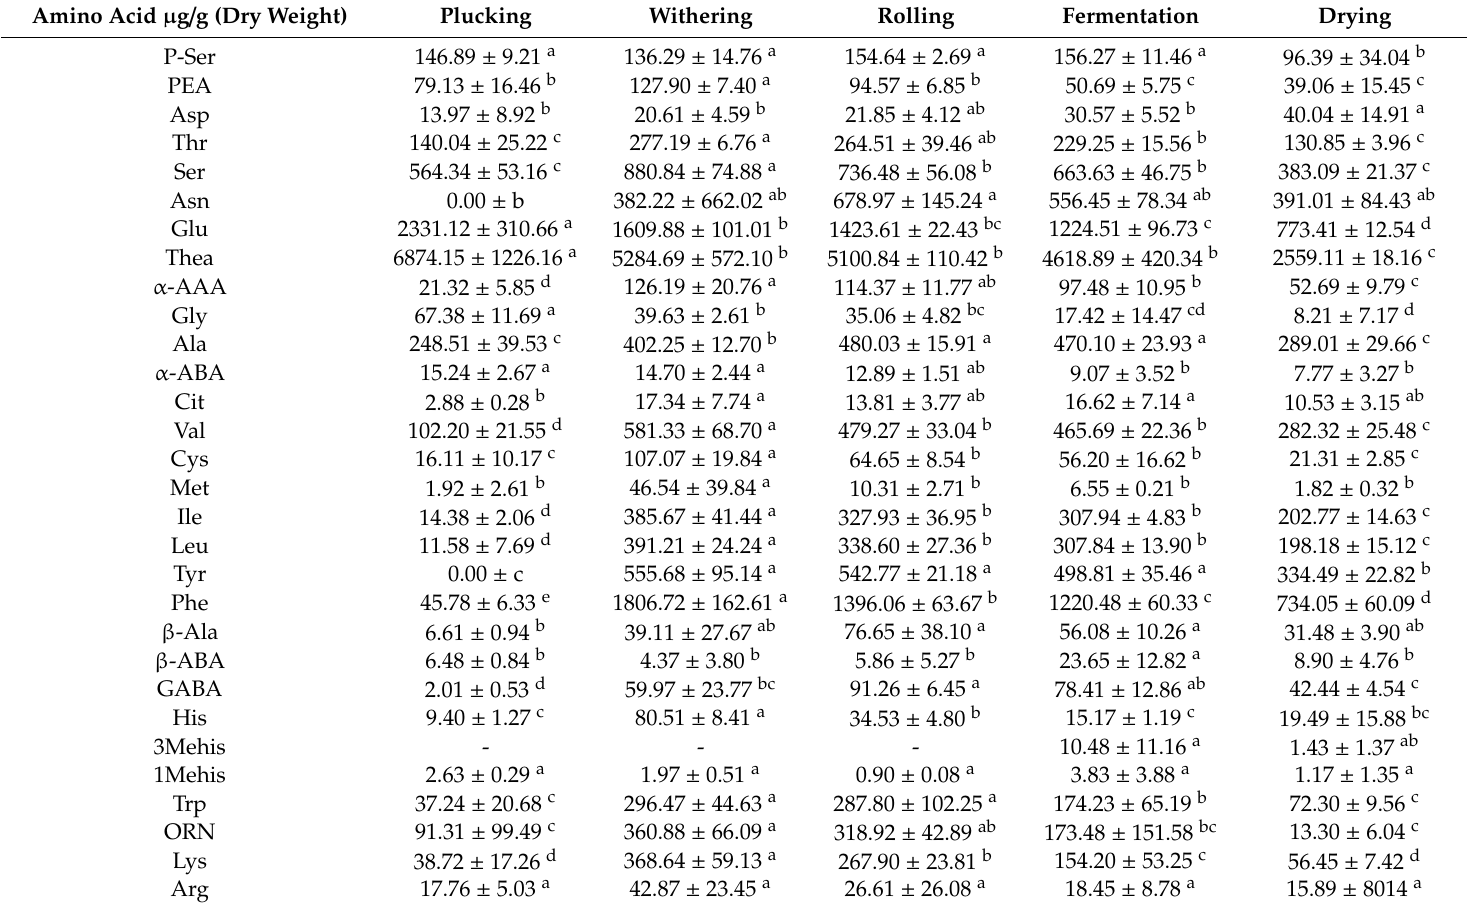
Table 1. Contents of free amino acids in black tea leaves during the manufacturing process. Amino Acid µ g / g (Dry